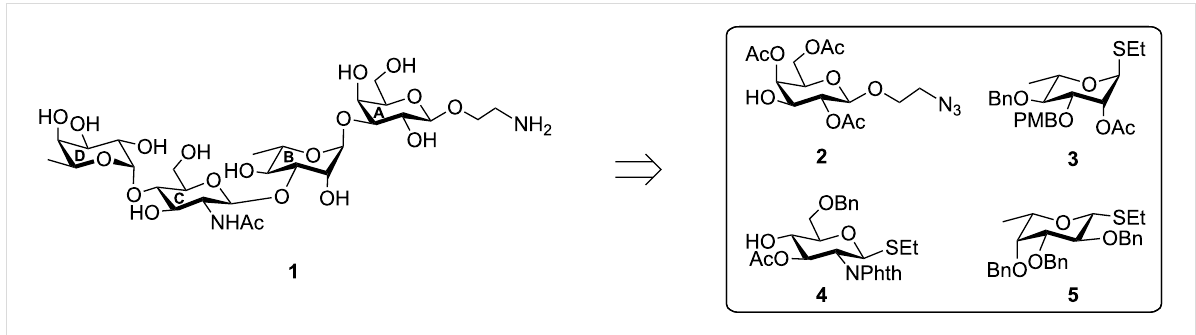
Figure 1: Structure of the synthesized tetrasaccharide and its precursor intermediates. PMB: p -methoxybenzyl.